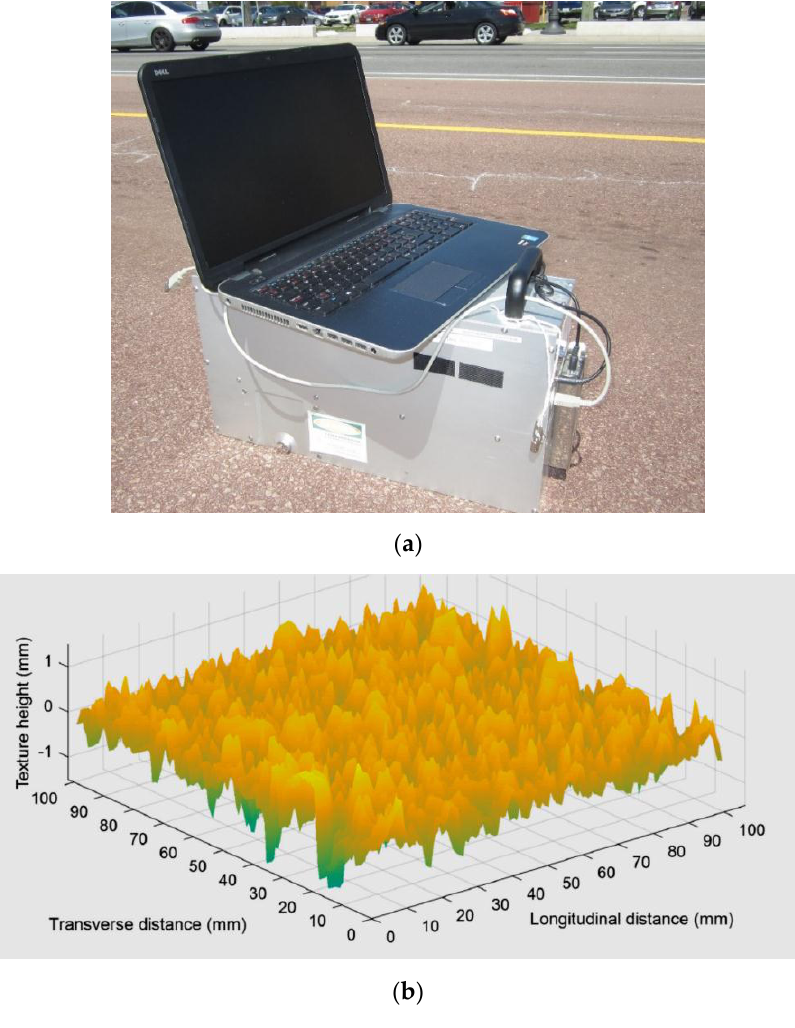
Figure 2. Pavement texture measurement: ( a ) a line-laser scanner; (b ) a recovered 3D texture height map.